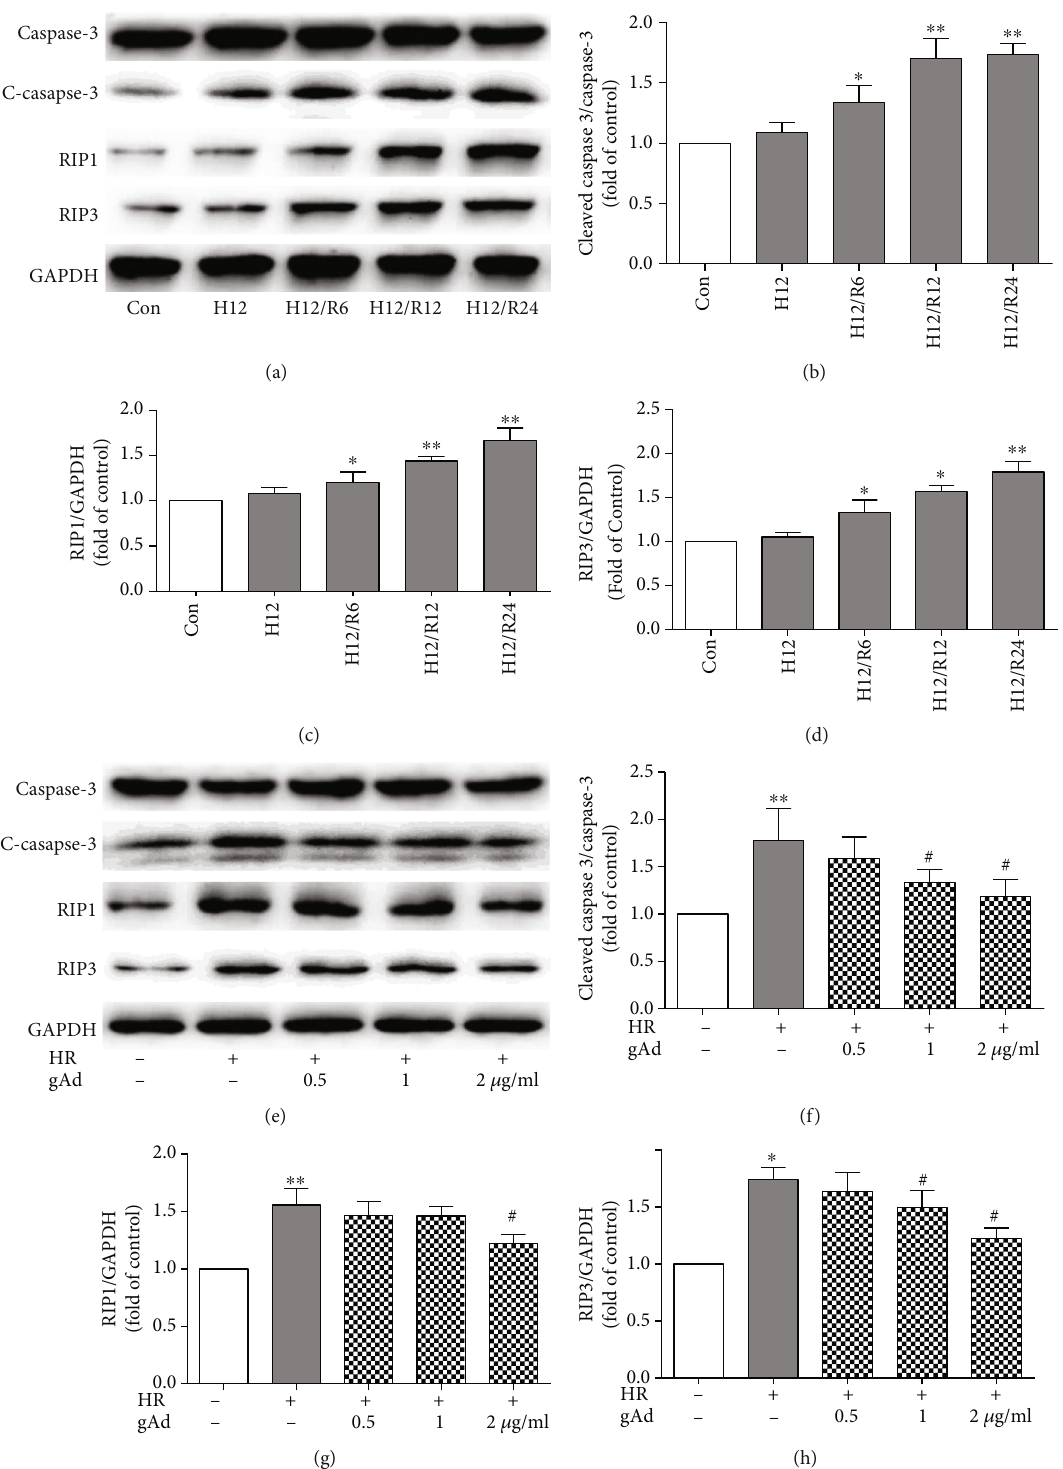
Figure 3: gAd could attenuate hypoxia/reoxygenation-induced cell apoptosis. (a) Hypoxia/reoxygenation (H12) and R0, 6, 12, and 24h response of activated (cleaved) caspase-3, RIP1, and RIP3 as assayed by Western blotting for NRVMs ( n = 3 ). (e) gAd (0, 0.5, 1, and 2 μ g/ml) suppressed hypoxia/reoxygenation-induced (cleaved) caspase-3, RIP1, and RIP3 as activation in a dose-dependent manner ( n = 4 ). (b – d, f – h) The bar fi gures show the protein expression rates of (cleaved) caspase-3, RIP1, and RIP3, respectively. ∗ P < 0 : 05 and ∗∗ P < 0 : 01 vs. the control group; # P < 0 : 05 vs. the H12/R12